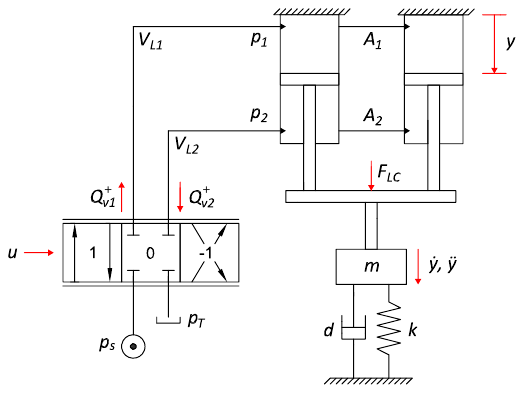
Figure 3: Modelling of the load cylinder